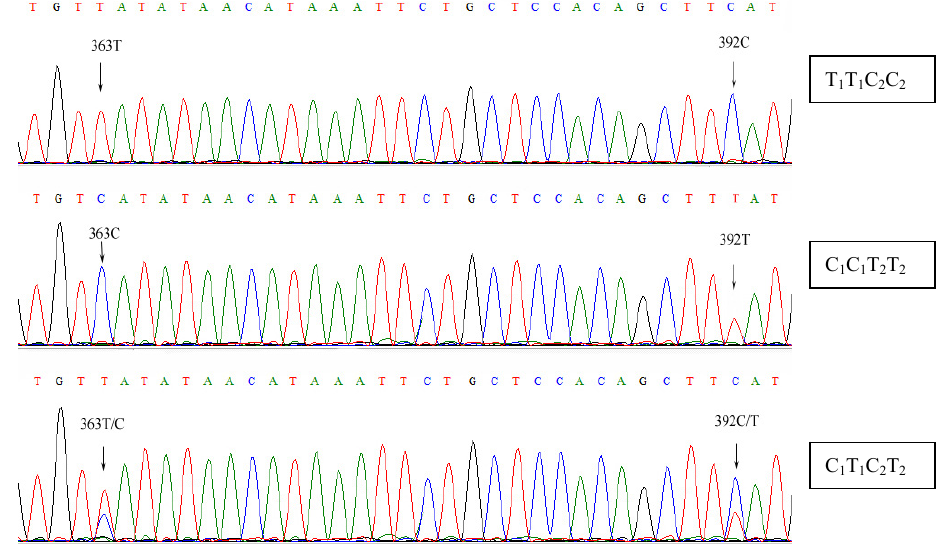
Figure 2. Sequencing results showing the sequence amplified by primer intron 11 of VLDLR gene containing 363T>C and 392C>T. The two mutations are linked with each other. T 1 T 1 C 2 C 2 genotype contains two 363T and two 392C single strands (allele T 1 C 2 ); the C 1 C 1 T 2 T 2 genotype contains two 363C and two 392T single strands (allele C 1 T 2 ) ; and the C 1 T 1 C 2 T 2 genotype contains one 363T–392C single strand and one 363C–392T single